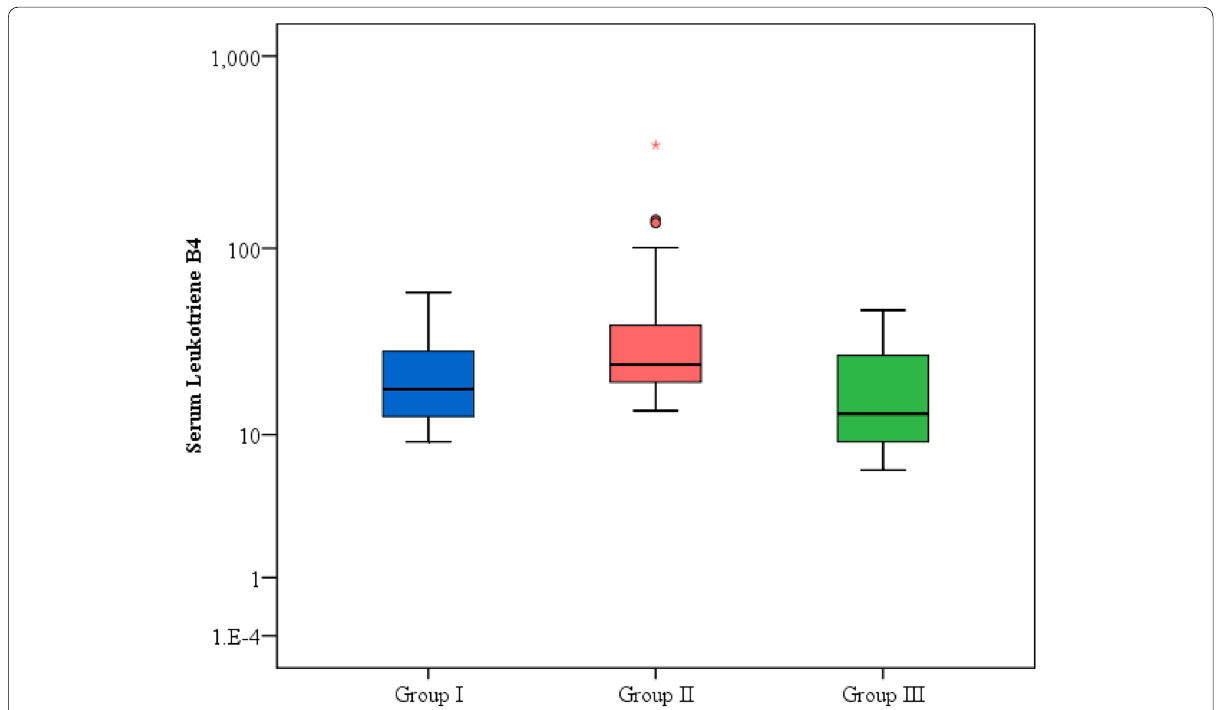
Fig. 1 Comparison between the three studied groups ( n